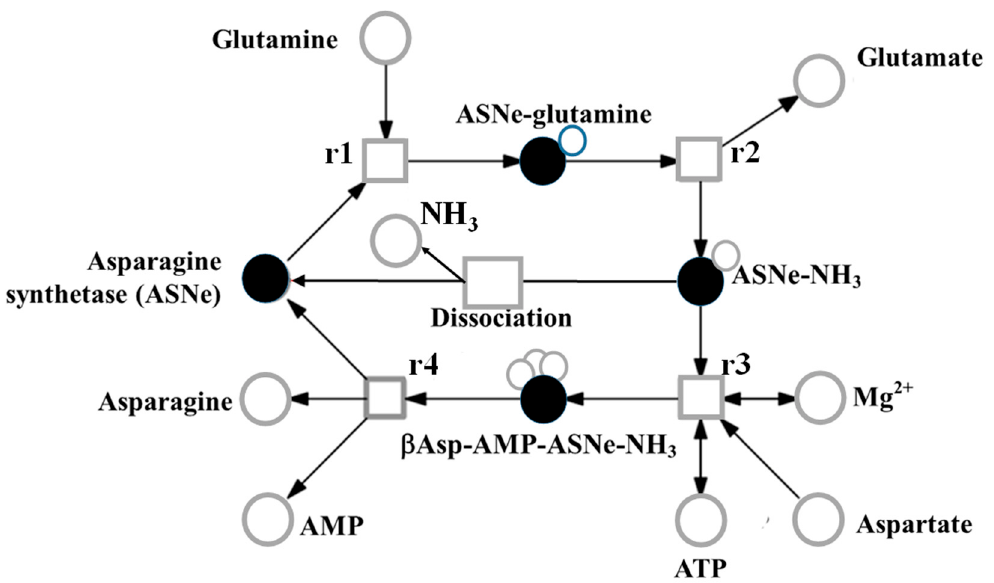
Figure 4. Model representing the reaction catalysed by asparagine synthetase, assuming mass action kinetics. The model comprises metabolites (open circles), the asparagine synthetase enzyme (closed circles), and reactions (squares), and features 12 molecules: AMP, ATP, asparagine (Asn), glutamine (Gln), glutamate (Glu), aspartate (Asp), asparagine synthetase enzyme (ASNe), ASNe complexed with glutamine (ASNe-Gln), ASNe complexed with ammonia (ASNe-NH 3 ), β -aspartyl-complex ( β Asp-AMP-ASNe-NH 3 ), magnesium ions, and ammonia. For clarity, water and pyrophosphate are not shown. Redrawn from [46].